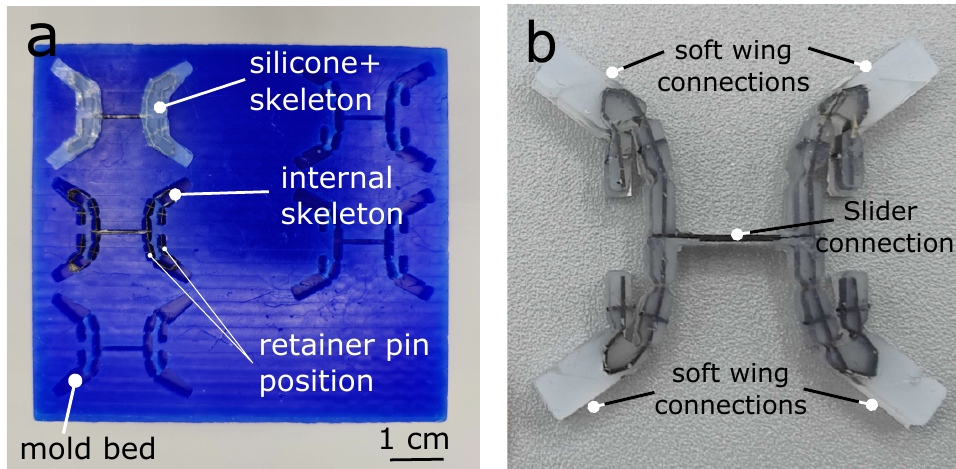
Figure 5. Assembly of a compliant “thorax”. ( a ) Photo of the machined wax mold. ( b ) Completed transmission with carbon fiber skeleton and silicone